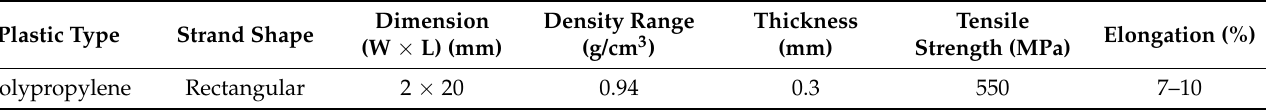
Table 2. Typical characteristics of the fabricated WPFT fibers used in this study.